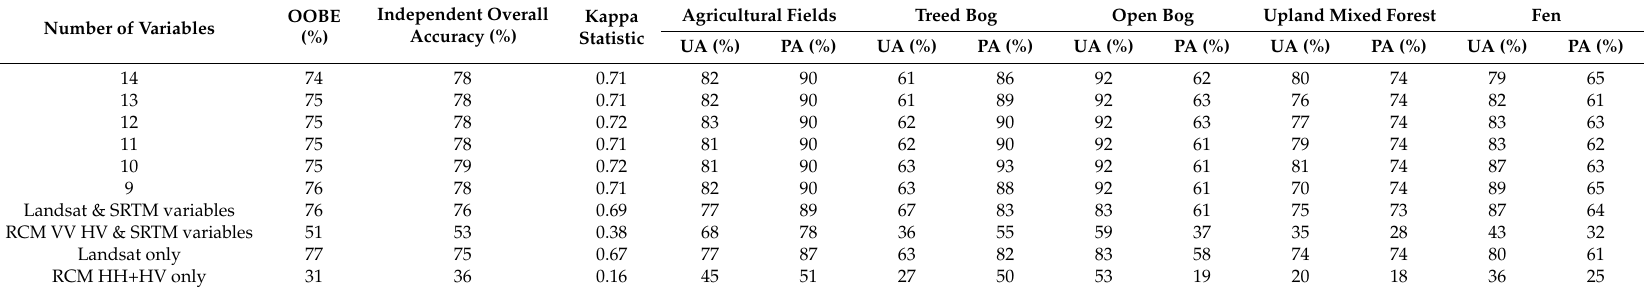
Table A13. Statistical results from the RCM Dual Pol VV+VH NESZ − 19 dB (13 July 2014), Landsat-8 (27 June 2014), SRTM variables summer model. The first iteration was run with all 14 variables, and variables ranked to be unimportant were then removed until 9 variables remained. The final variables in the model with the highest independent overall accuracy (10 variables) in order of decreasing importance were the seven Landsat-8 bands, HV Intensity, SRTM DEM, and SRTM